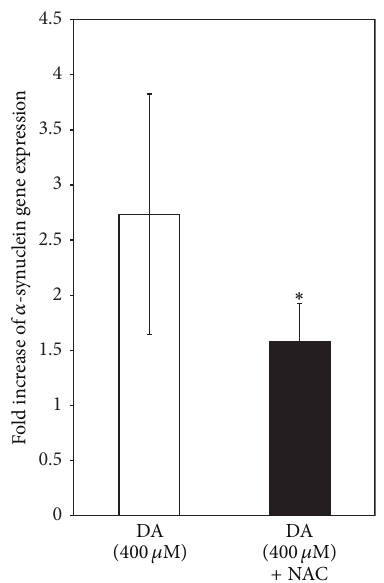
Figure 8: DA effects on 𝛼 -synuclein gene expression in SH-SY5Y cells. SH-SY5Y cells were incubated alone (control) or with DA (400 𝜇 M) or 400 𝜇 MDA plus 2.5 mM NAC for 24 h. Cellular RNA was isolated and quantitative RT-PCR was carried out for 𝛼 - synuclein gene as detailed in Section 3. Results expressed as the fold increase with respect to the control are the means ± SD of six observations. Statistical significance collected by Student’s 𝑡 -test, paired, shows significant difference ( ∗ 𝑃 < 0.05 ) in the fold of alpha- synuclein gene expression between the DA-treated group (M = 2.73, SD = 1.09) and the NAC co-treated group (M = 1.57, SD = 0.34); 𝑡 (5) =